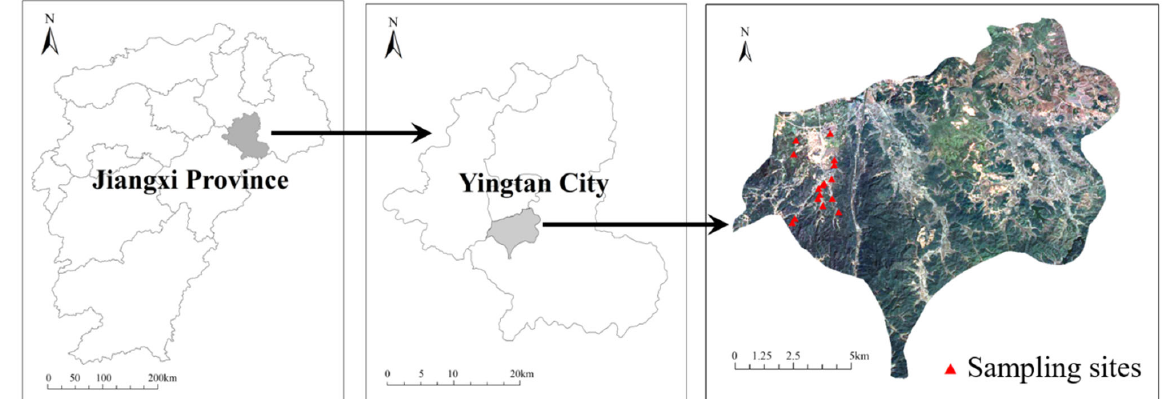
Figure 1. Location of the Yingtan City, the study area and sampling sites. Sixteen soil (0–25 cm) and corresponding rice grain samples were collected from the farmland along the Luxi River (8.57 km 2 ). To minimize the heterogeneity and uncertain ‐ ty, each soil sample was sampled by five subsamples by the quincunx sampling method,